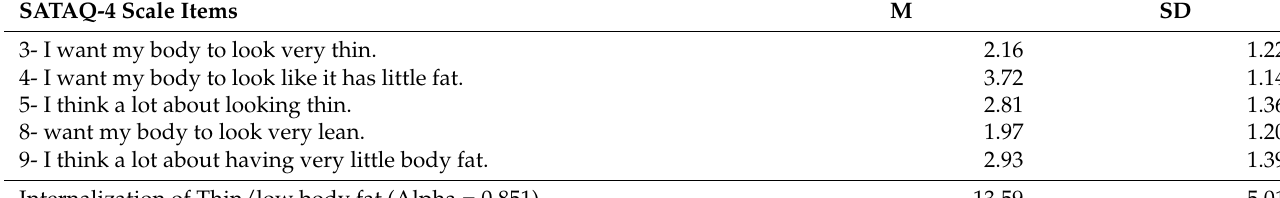
Table 1. Means and standard deviations of the items on the SATAQ-4 scale and BAS-2